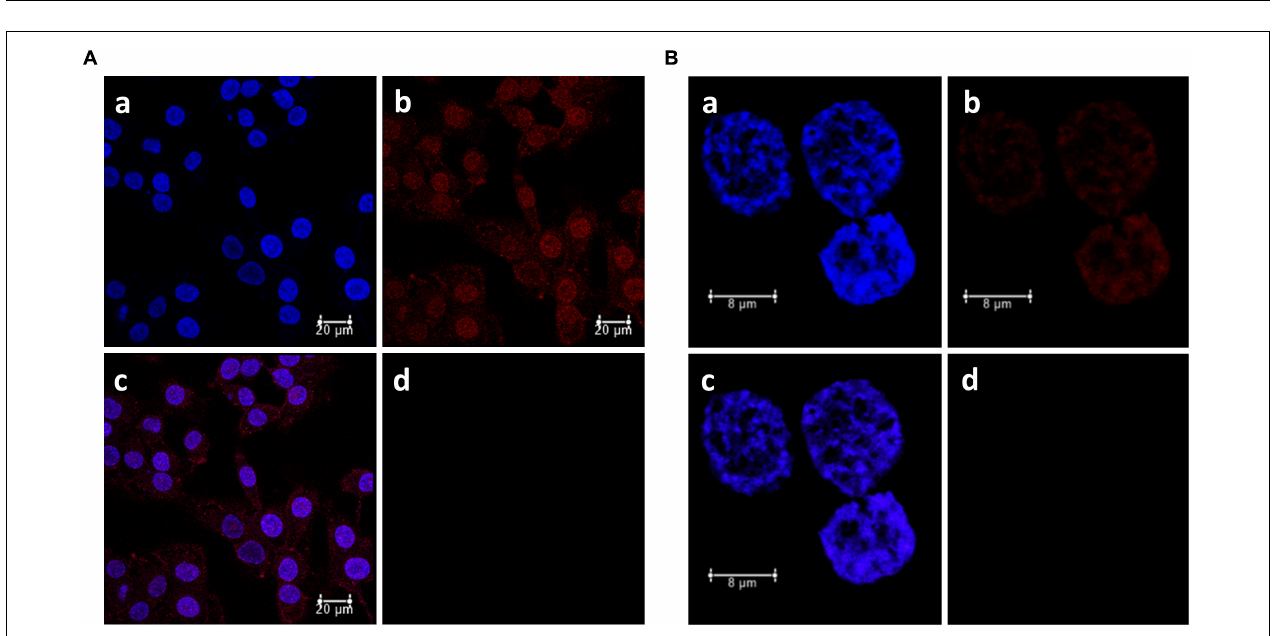
FIGURE 7 | Phototoxicity of free porphyrin ( P ) and porphyrin immobilized on hybrid nanoparticles ( P-HNP ) in T24 cells using ATP bioluminescent assay after treatment of 6 h followed by PDT with 10 J/cm 2 of fluence. Negative control (NC)-untreated cells (cells + RPMI medium). The results are presented as mean ± SD ( n = 3). Significant differences relative to free P and P-HNP are indicated with an asterisk. Statistical significance: *** p < 0.001, ** p < 0.01. Data obtained by two-way ANOVA analysis with post-tests of Bonferroni.